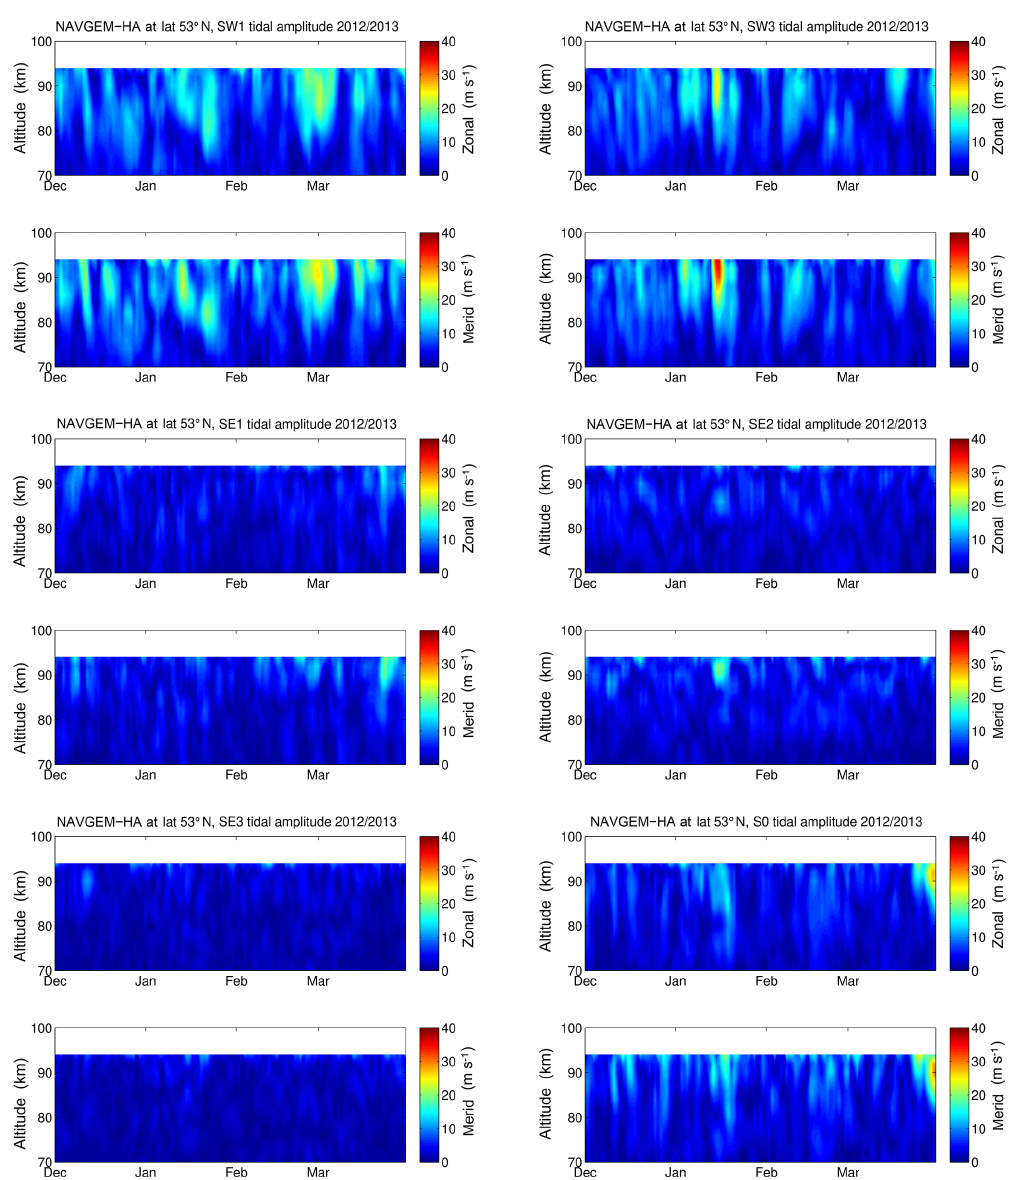
Figure B4. The same as Fig. 13 but above Juliusruh and for the winter of